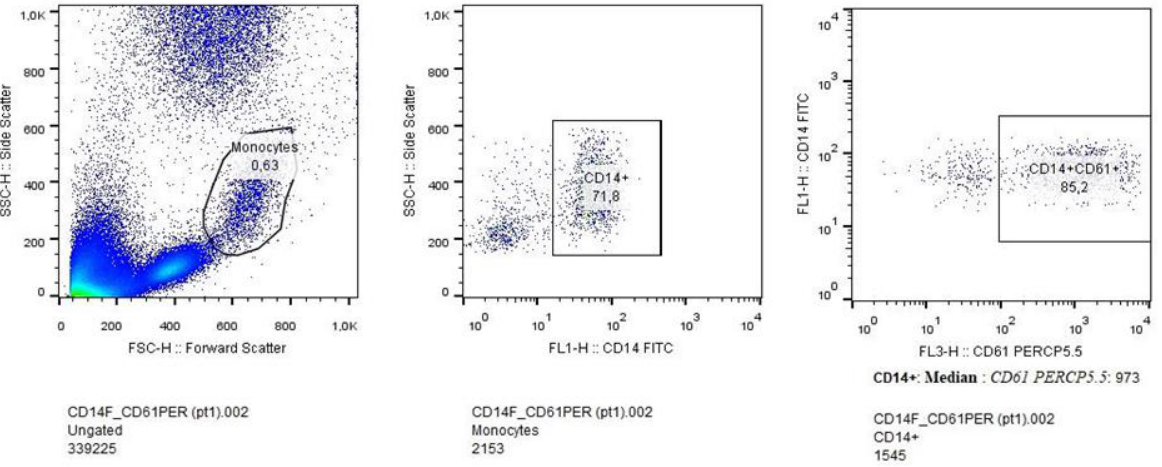
Figure 1. Monocyte selection process. The monocyte population was selected using flow-cytometry based on CD14 membrane receptor expression. The subpopulation forming complexes with platelets (CD61+) was then identified.